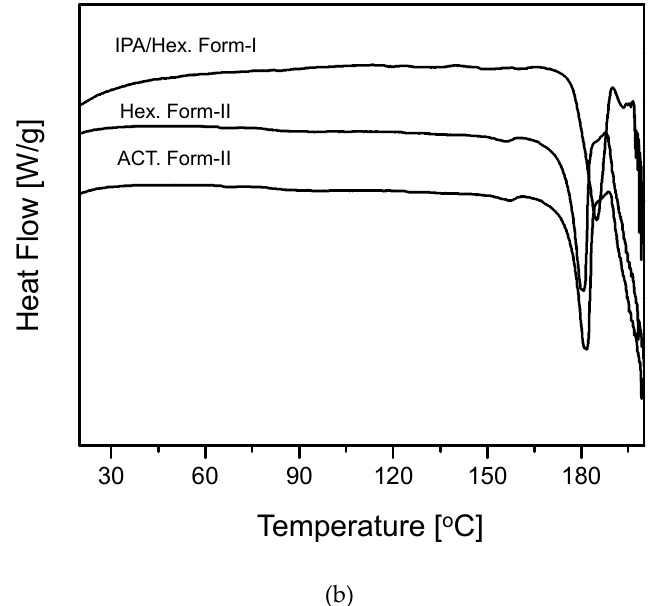
Figure 3. IPX/Hex, Hex and ACT Anti-solvent dependent CLP crystals ( a ) powder X-ray diffraction (PXRD) patterns, ( b ) Differential scanning calorimetry (DSC).